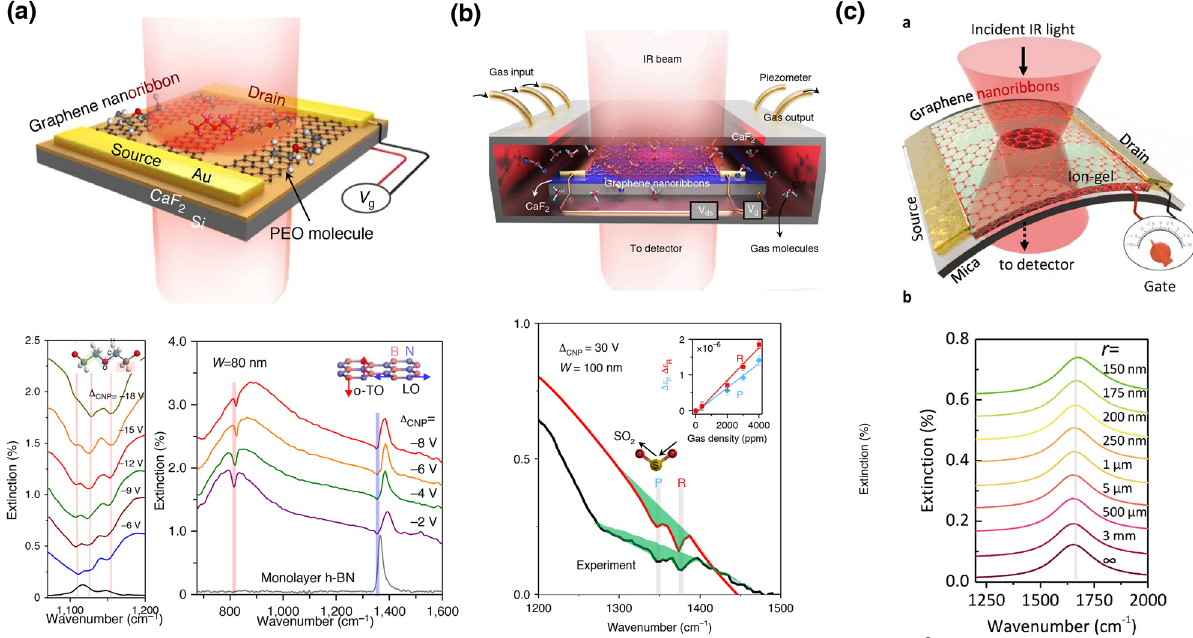
Figure 3: Graphene nanoribbon-based SEIRA structures. (a)Aschematicofthesensorandelectrically-controlledSEIRAspectraofpolyethyleneoxide(PEO)thinfilmandh-BNmonolayer.(b)Aschematic of the gas sensor and SEIRA spectra of SO 2 molecules. (c) A schematic of the fl exible sensor and calculated extinction spectra of free-standing graphene plasmon on arc nanoribbons bending. [(a) Reproduced with permission from reference [52]. Copyright © 2016, Nature Publishing Group; (b) reproduced with permission from reference [57]. Copyright © 2019, Nature Publishing Group. (c) Reproduced with permission